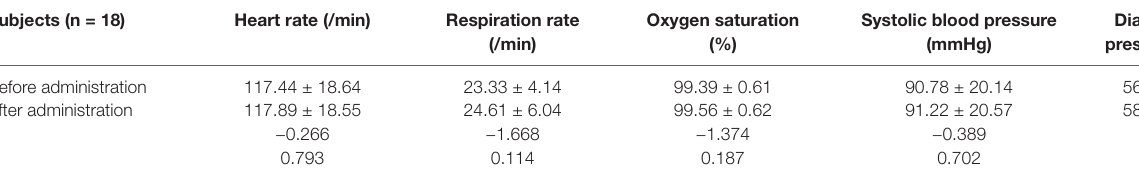
TABlE 4 | The vital signs of the participants in sedation with chloral